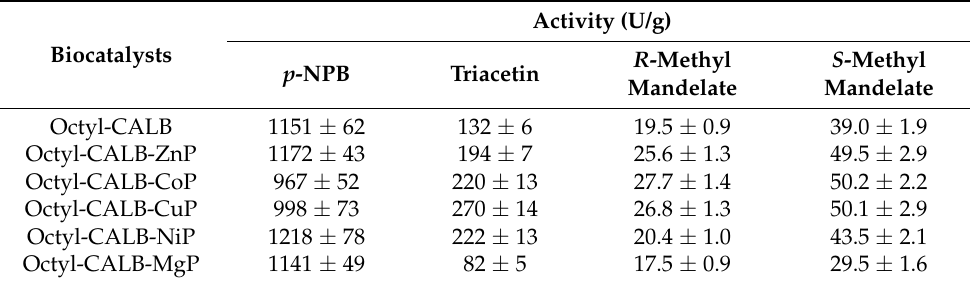
Table 6. Specific activity of different CALB biocatalysts with 1 mM p -NPB (pH 7 and 25 ◦ C), 50 mM triacetin (pH 7 and 25 ◦ C), and 50 mM R - or S -methyl mandelate (pH 7 and 25 ◦ C). Experiments were conducted as described in